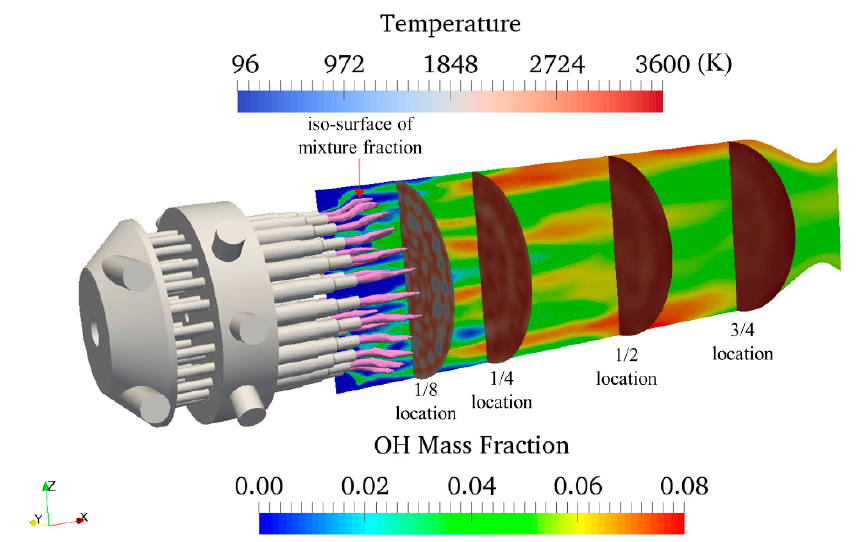
Figure 7. Transverse slice contours of the temperature at four axial locations, longitudinal slice contour of OH mass fraction, and iso-surface of the mixture fraction value of 0.004 (represented in pink).